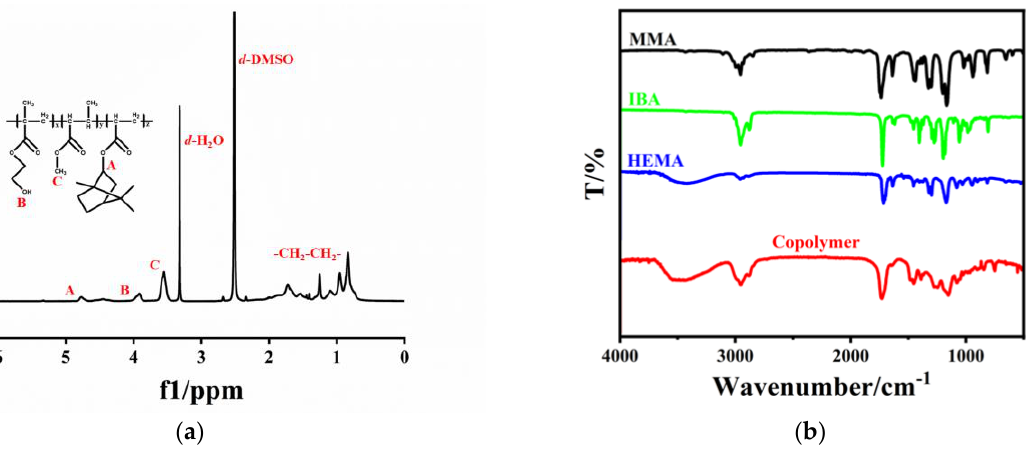
Figure 1. Structural characterization of copolymers ( a ) 1 H−NMR spectra; ( b ) FT−IR spectra.